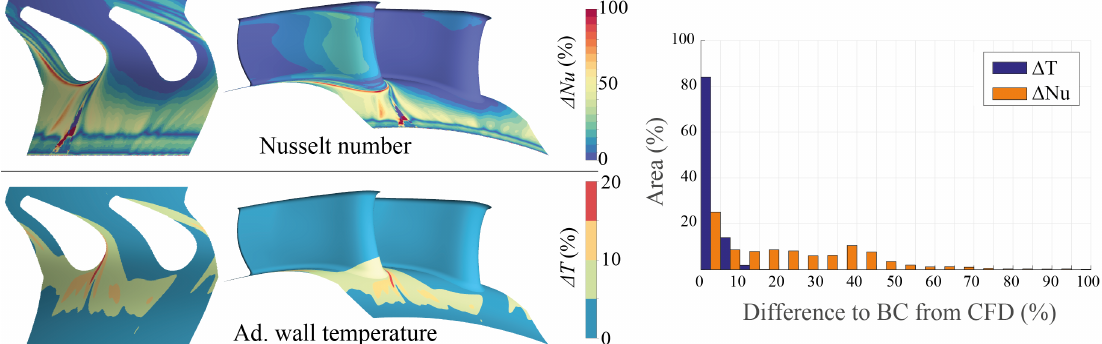
Figure A5. Effect of error in inlet turbulence distribution. Ad.: